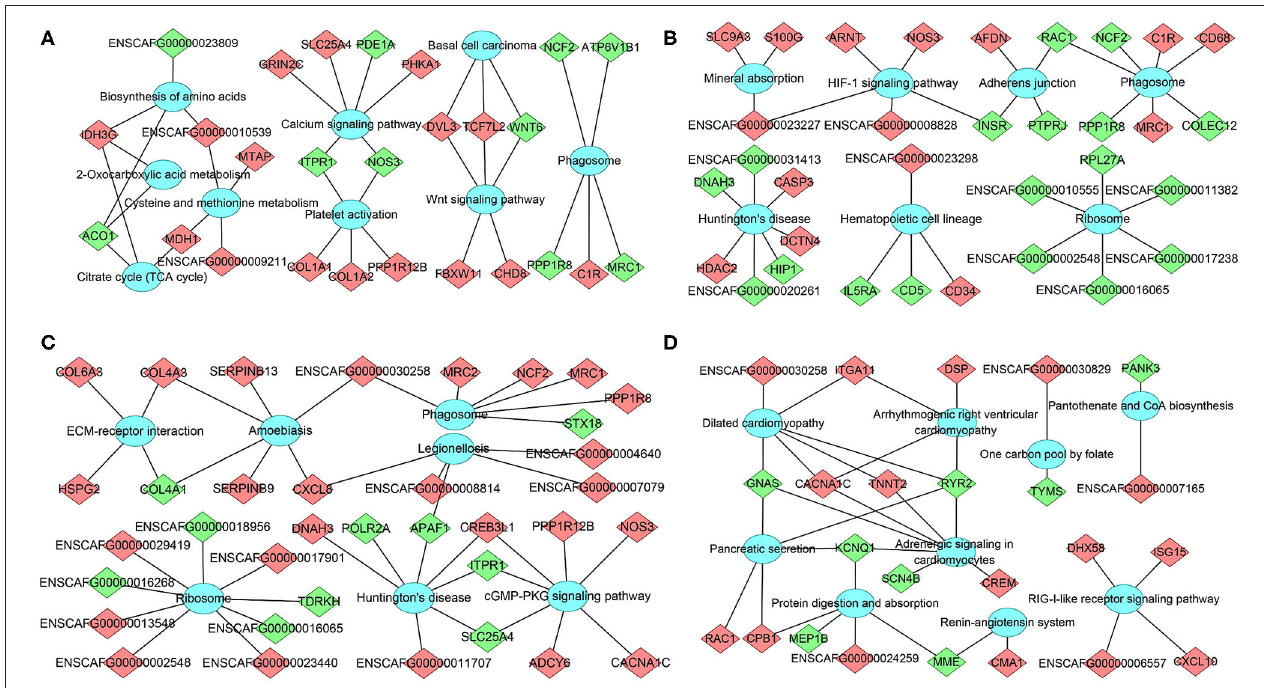
FIGURE 6 | The network of DEmRNA-pathway using KEGG analysis at (A) 12 hpi, (B) 24 hpi, (C) 96 hpi, and (D) 36 dpi. Diamonds represent the DEmRNA, and ellipses represent the significantly enriched pathways. Red color indicates upregulation, while green color indicates